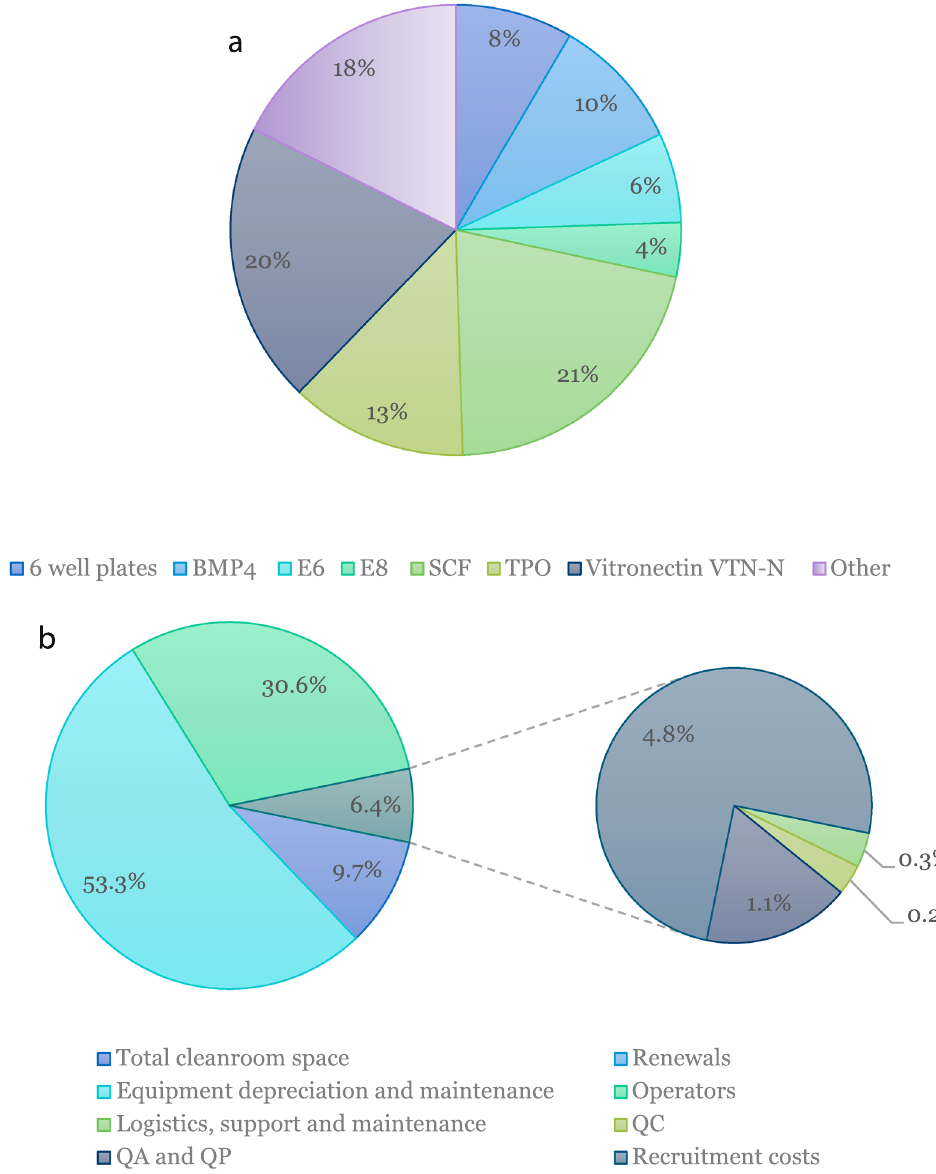
Fig. 4 Cost of materials and facility costs of manufacture. a Breakdown of the reagents and consumables having the most signi fi cant contribution to the cost of reagents (CoRs). BMP4 Bone Morphogenic Protein 4, E6 and E8: iPSC media, SCF Stem Cell Factor, TPO Thrombopoietin. b Fixed cost break down after year 5 after production ramps up to meet consistent yearly dose